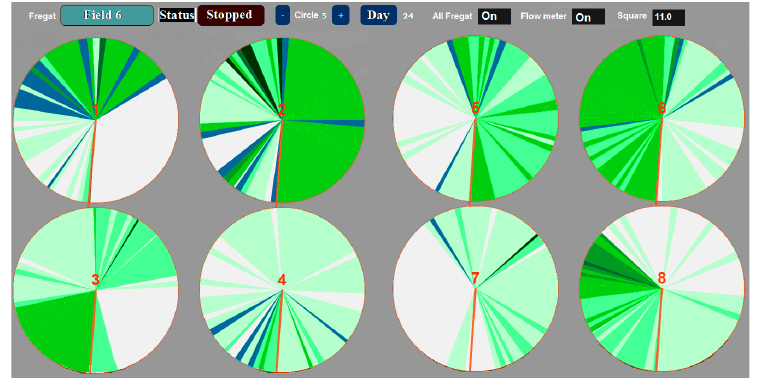
Figure 4. Operating diagram of an irrigation machine.